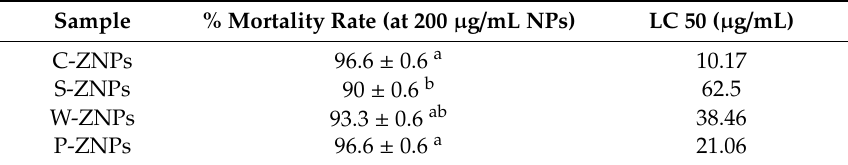
Table 3. Lethality of the synthesized ZnO NPs against brine